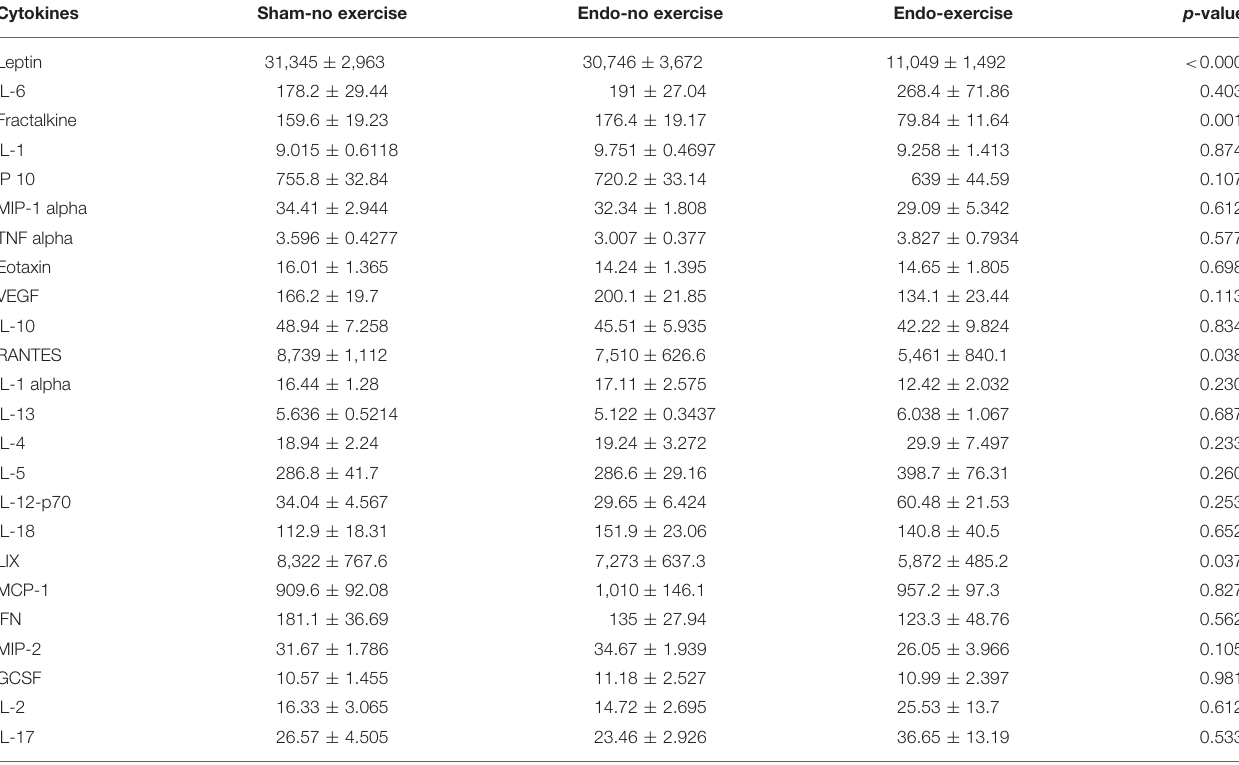
TABLE 1 | Cytokine levels in serum. Cytokines Sham-no exercise Endo-no